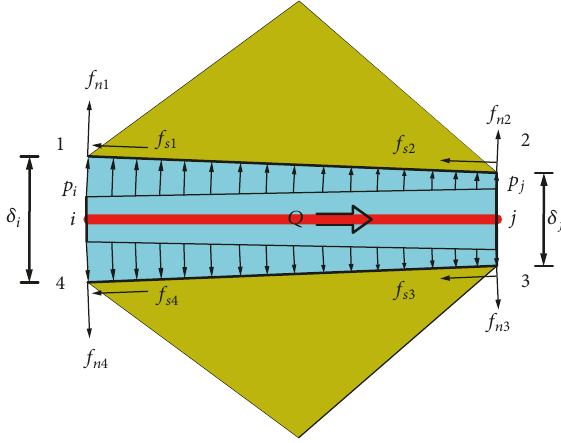
Figure 10: Fluid pressure acting on element boundaries.